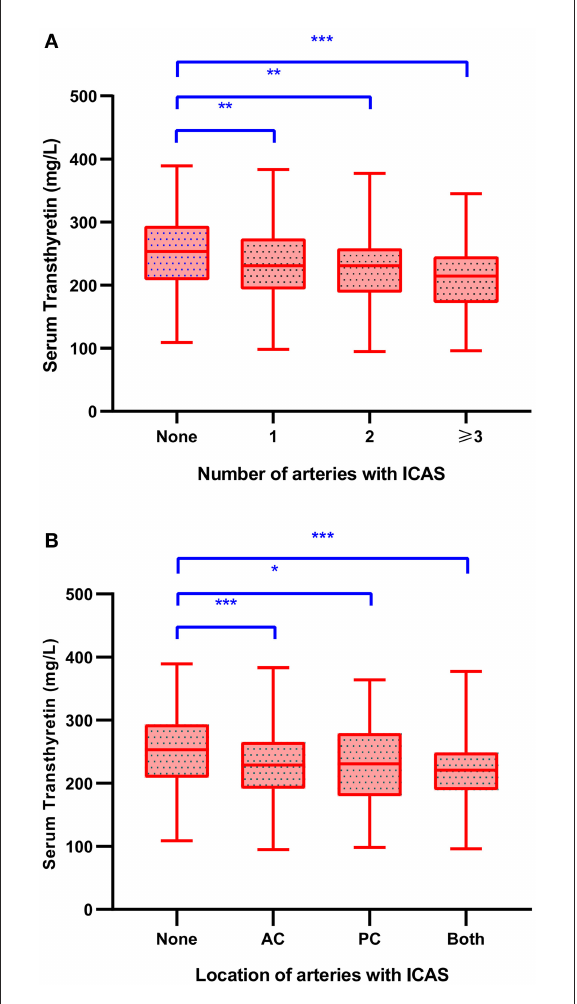
FIGURE2 Serum transthyretin levels in stroke patients with different number (A) and location (B) of stenotic intracranial